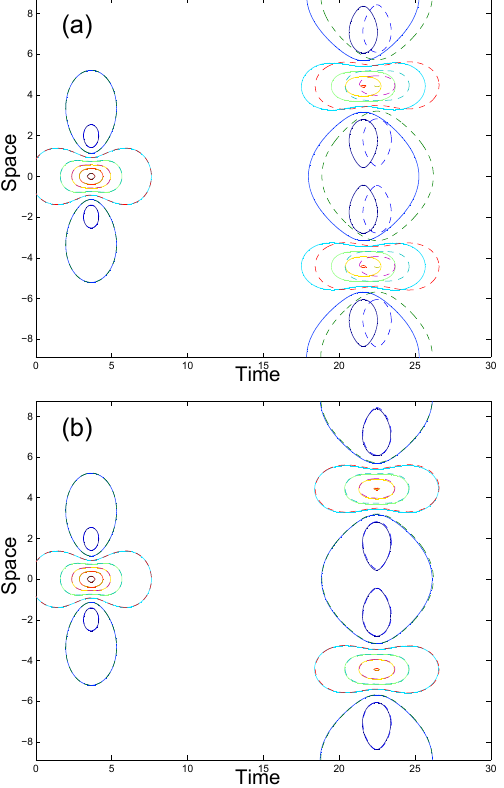
Figure 9. Contours of | U (cid:15) (x,t) | for f 5 (x) (dashed line) and the two-mode SPB (solid line) given by (a) | U ( 1 , 2 ) (x,t ; ρ ∗ ,τ 0 ) | and (b) | U ( 1 , 2 ) (x,t ; ρ ∗ ,τ ∗ ) | .